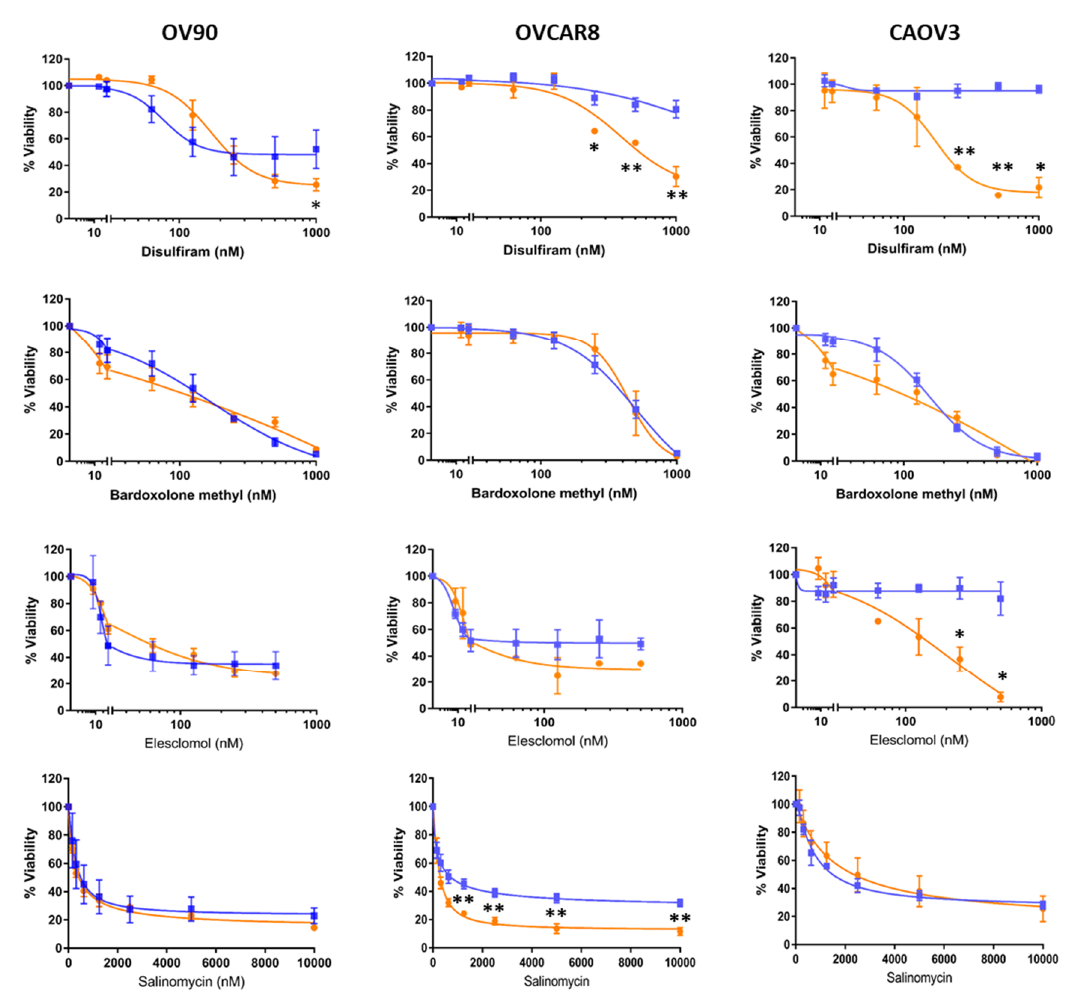
Figure 2. Confirmation of the candidate drug’s activity against ovarian cancer cells. Dose response curves of selected agents on additional cell lines grown in adherent (blue) or TIC-enriching spheroid (orange) culture conditions. Graphs represent mean and SEM compared to control * p < 0.05, ** p <